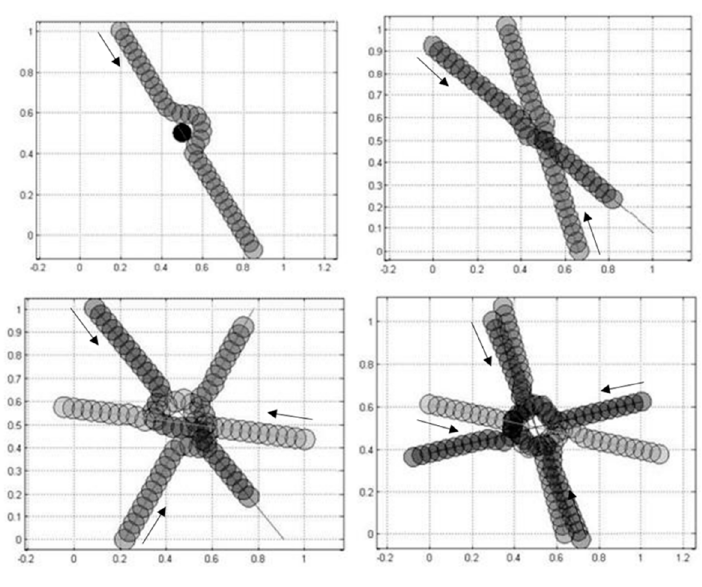
Figure 9. Validation results.